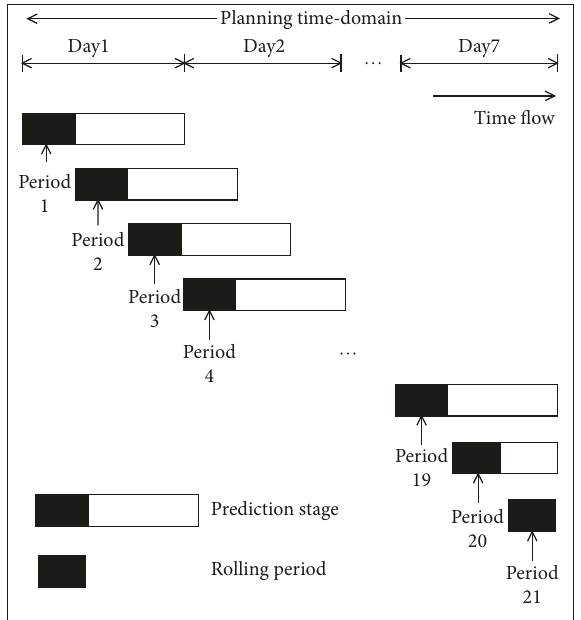
Figure 4: Division of periods of rolling time-domainin the case